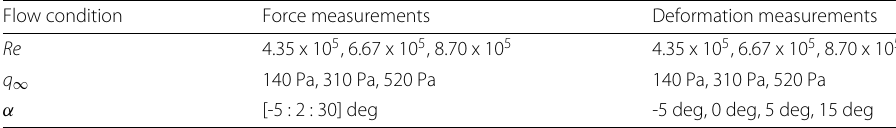
Table 1 Summary of the different tests and measurement techniques Flow